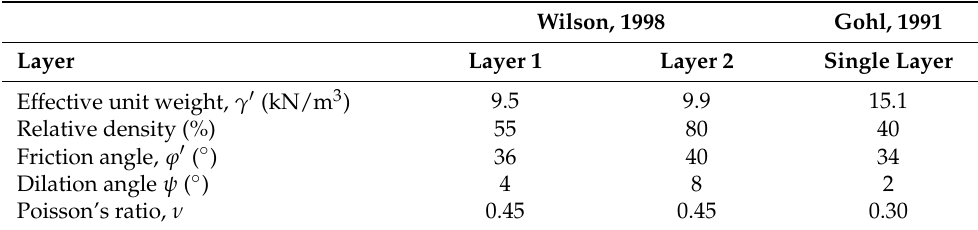
Table 1. The soil parameters selected for the verification analyses.